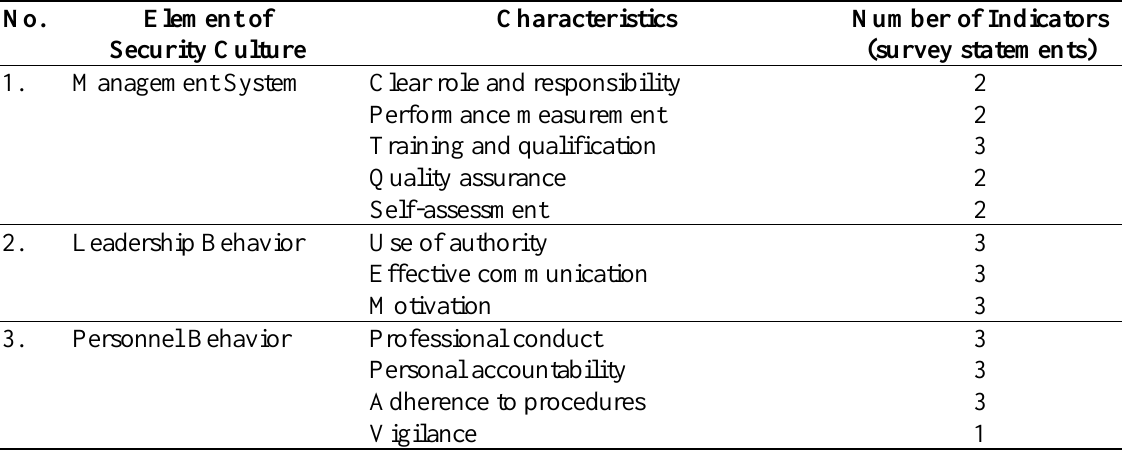
Table 1. The elements, characteristics, and number of indicators used in the